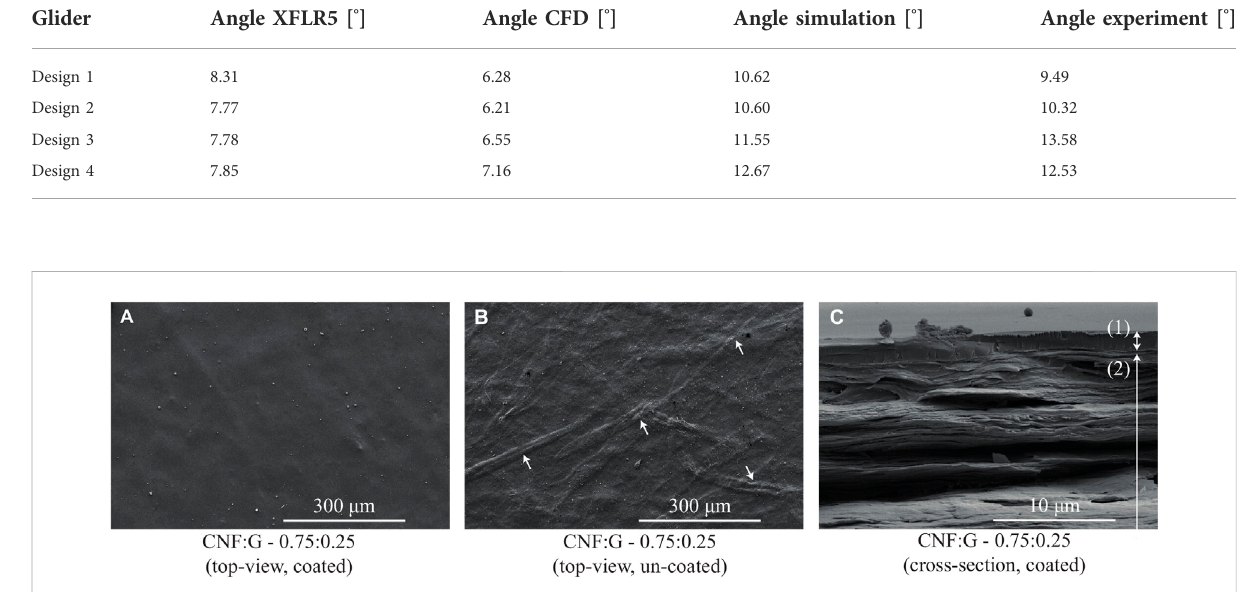
FIGURE 6 SEM images of the CNF:G — 0.75:0.25 fi lms produced at an accelerating voltage of 5 kV. (A) shows the top view of the CNF:G fi lm coated with shellac, (B) gives the top-view of the CNF:G fi lm without the shellac coating. The arrows indicate fi bers that are visible within the composite fi lm matrix, (C) shows a cross-sectional view of the CNF:G fi lm illustrating the approximately 1.5 μ m coating. Label (1) indicates the thickness of the coating, while label (2) indicates the CNF:G composite